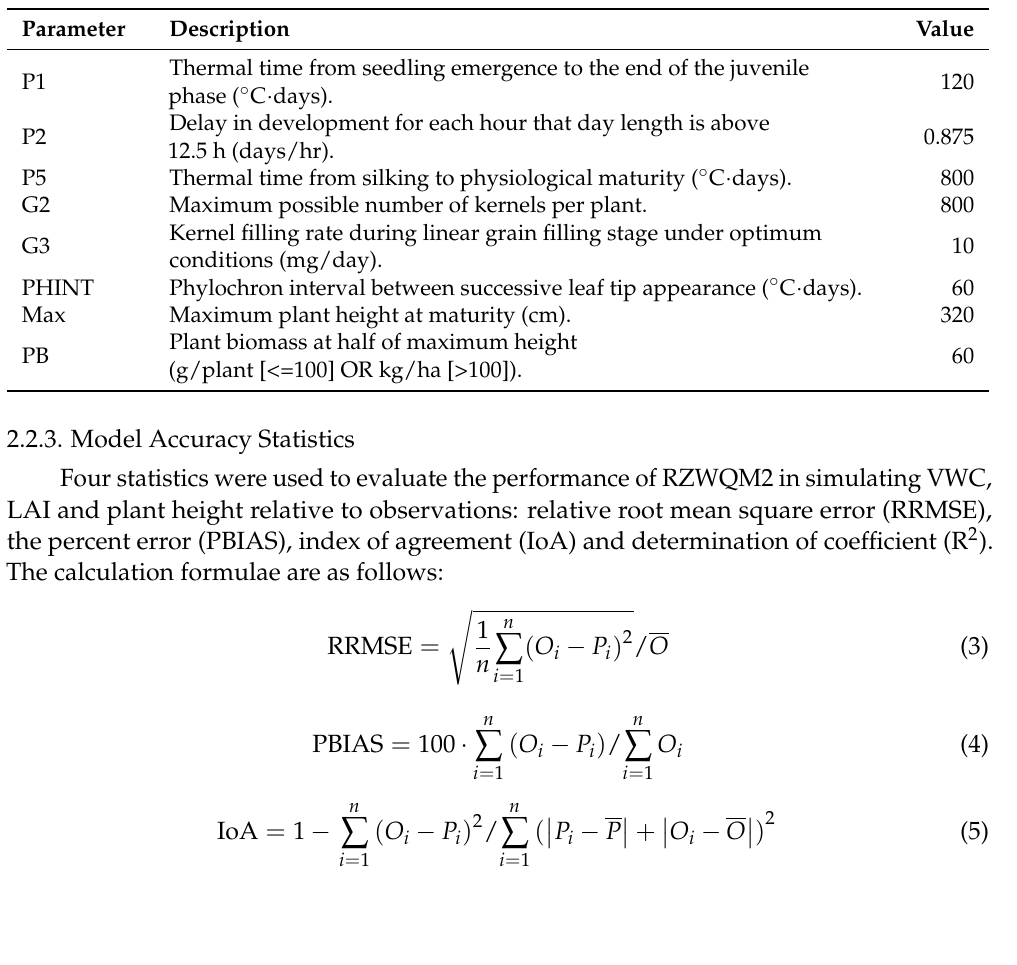
Table 3. Calibrated crop development parameters for maize ( Zea mays